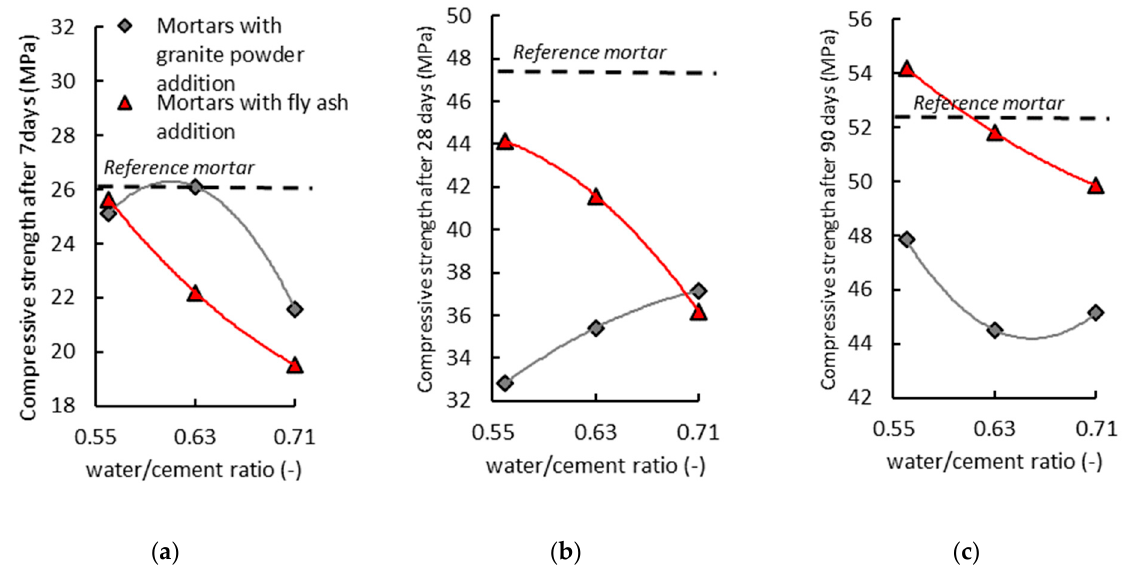
Figure 13. The effect of the water/cement ratio (w/c) on the compressive strength ( f cm ) of the air-cured hardened cementitious mortars: ( a ) after 7 days, ( b ) after 28 days, and ( c ) after 90 days.